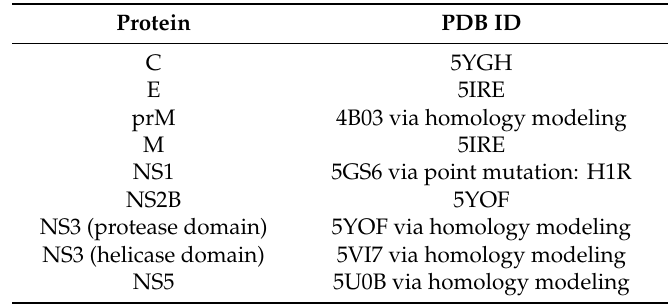
Table 7. Accession, origin and isolation year for Zika polyprotein sequences used to obtain consensus sequence.